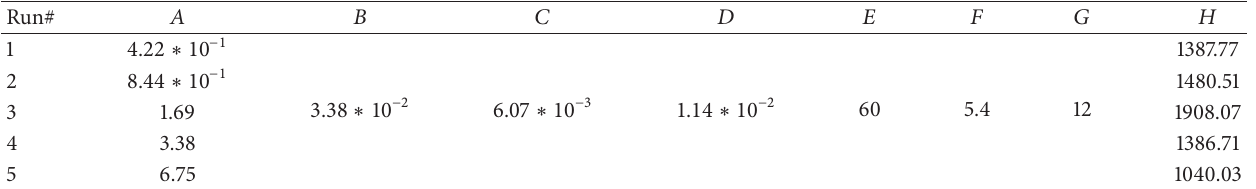
Table 3: Reactions conditions with different monomer concentrations.